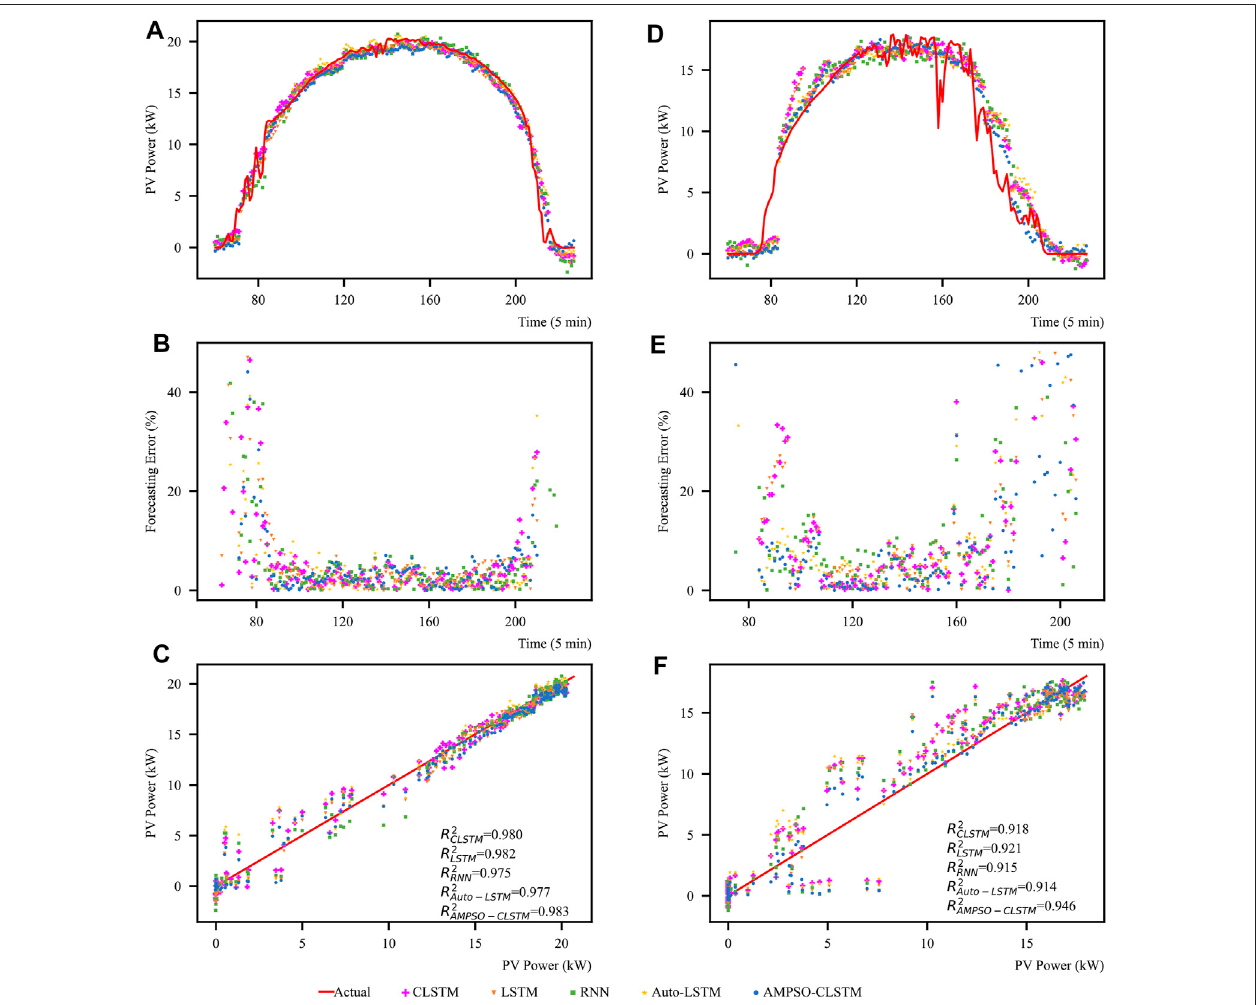
FIGURE 7 | Forecasting result analysis for Alice Spring on a sunny day and a rainy day. (A,D) plot the observed PV power on the selected sunny and rainy days, respectively, as well as the predicted values for each model. (B,E) plot the percentage errors of the predicted values and the observed values. (C,F) plot the regression analyses for the sunny and rainy days.